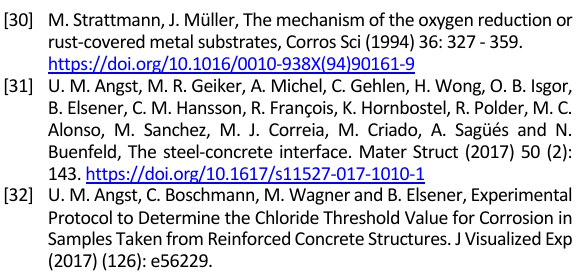
Protocol to Determine the Chloride Threshold Value for Corrosion in Samples Taken from Reinforced Concrete Structures. J Visualized Exp (2017) (126):